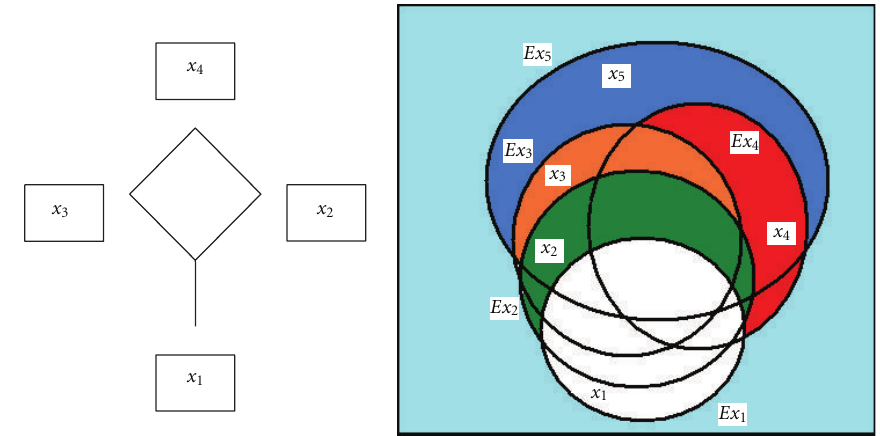
Figure 4: Generic representation of graph and HG.